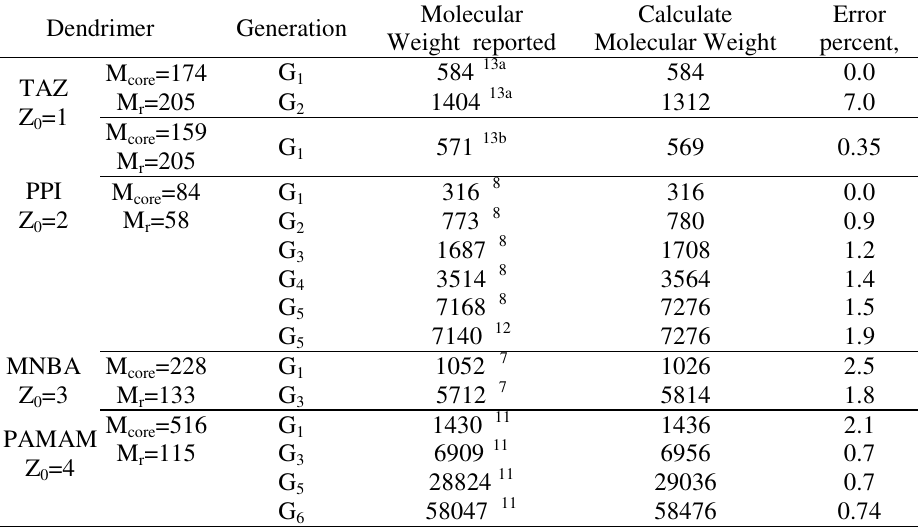
Table 3. The number of surface branches for AB